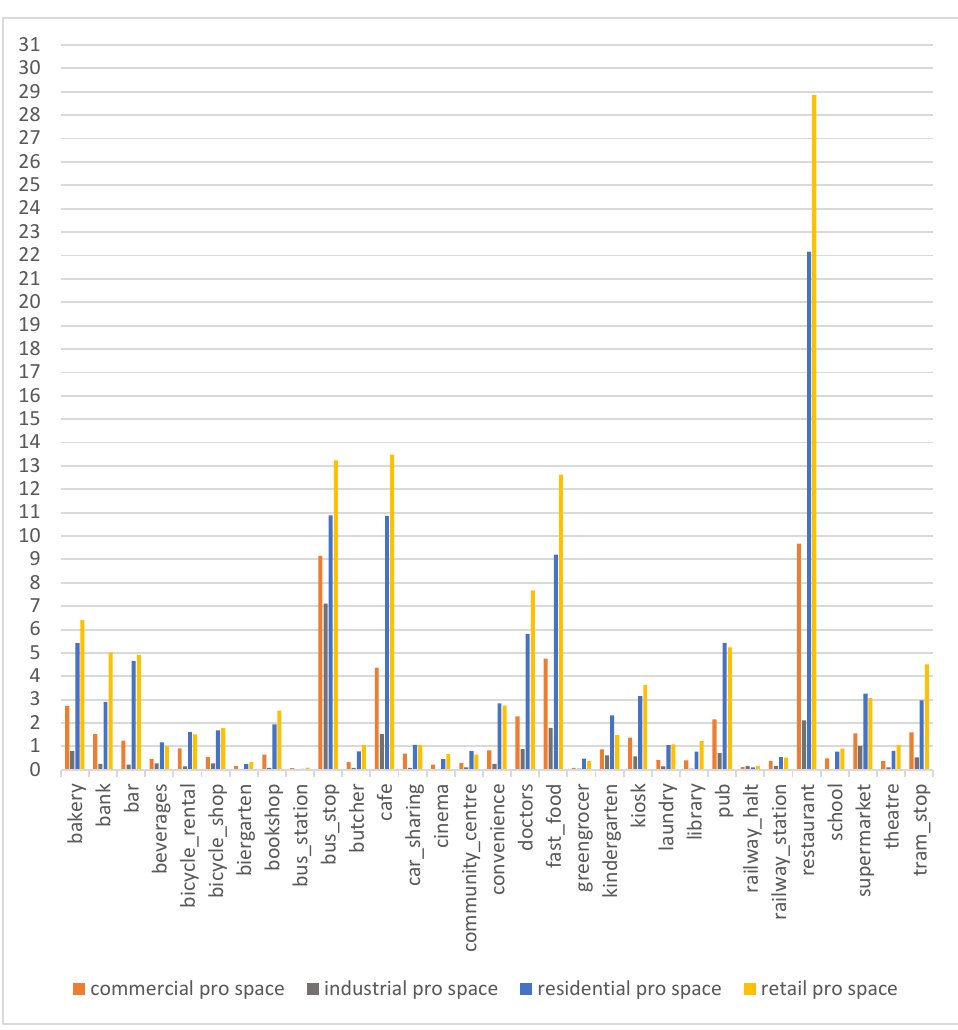
Figure 7. Average number of different POIs per coworking space in the vicinity of 500 m in the surrounding of coworking spaces in non-peripheral areas compared with the category of land use where the coworking space is located.